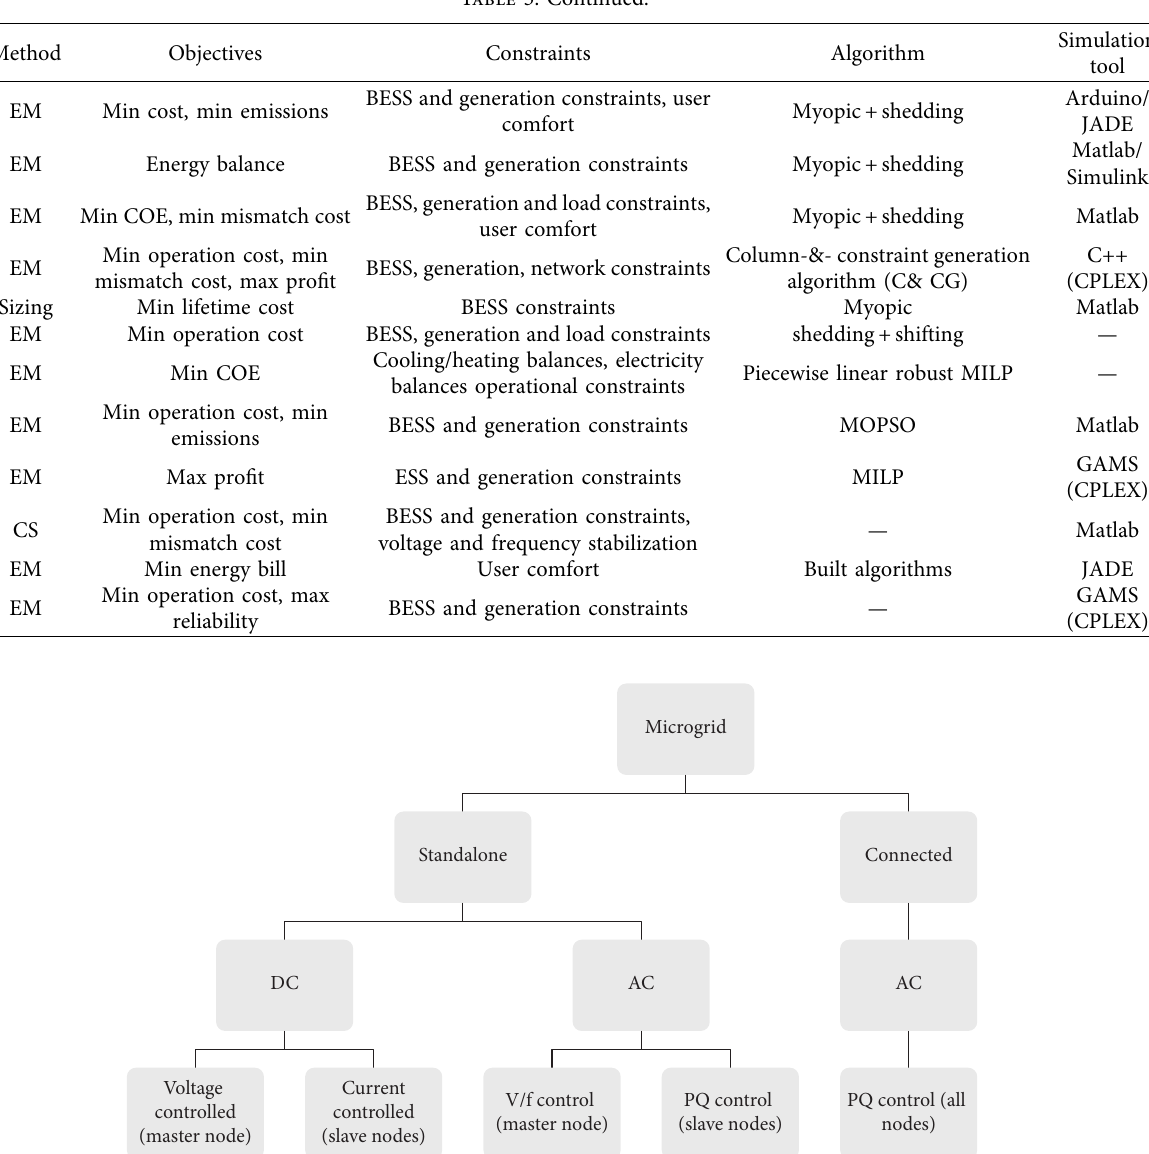
Figure 6: Summary of control schemes for